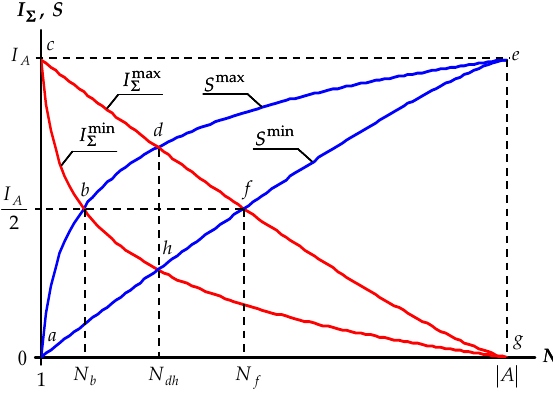
= A ( | A | = 100 ) . Figure 8. Information field of reflection of discrete systems